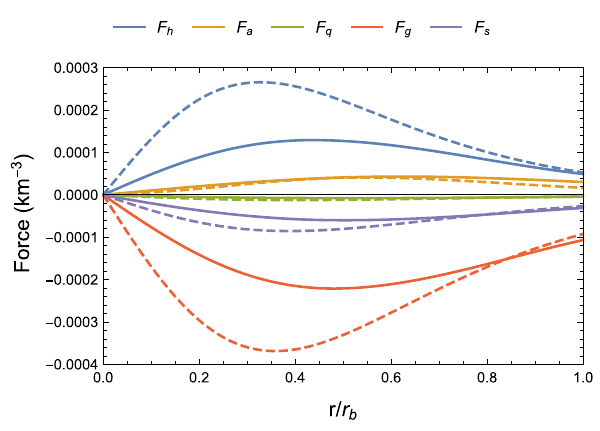
Fig. 3 Force profiles at f = 0 . 7 for K = − 2 (solid) and K = − 20